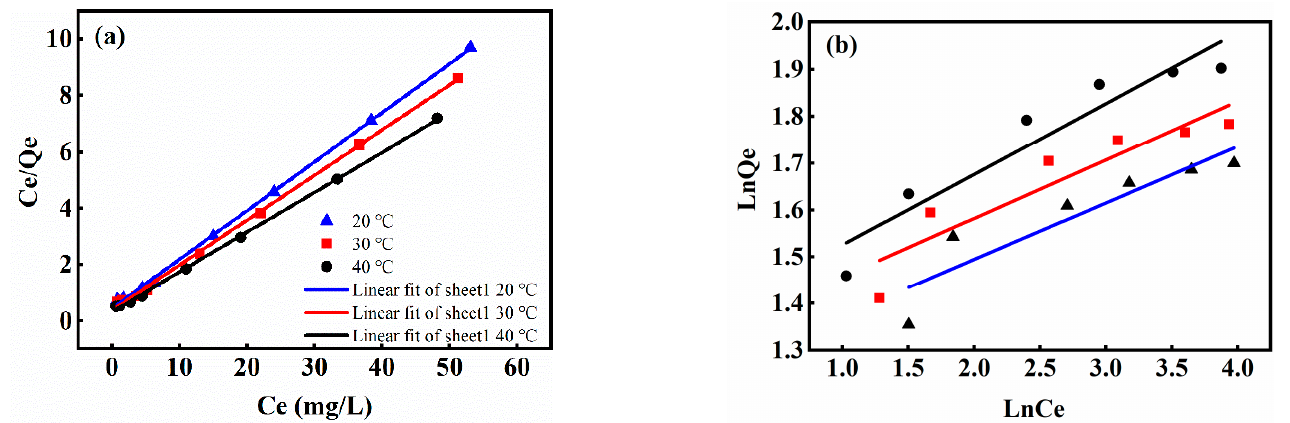
Figure 9. Pb adsorption isotherm model fitting: ( a ) Langmuir model; ( b ) Freundlich model .